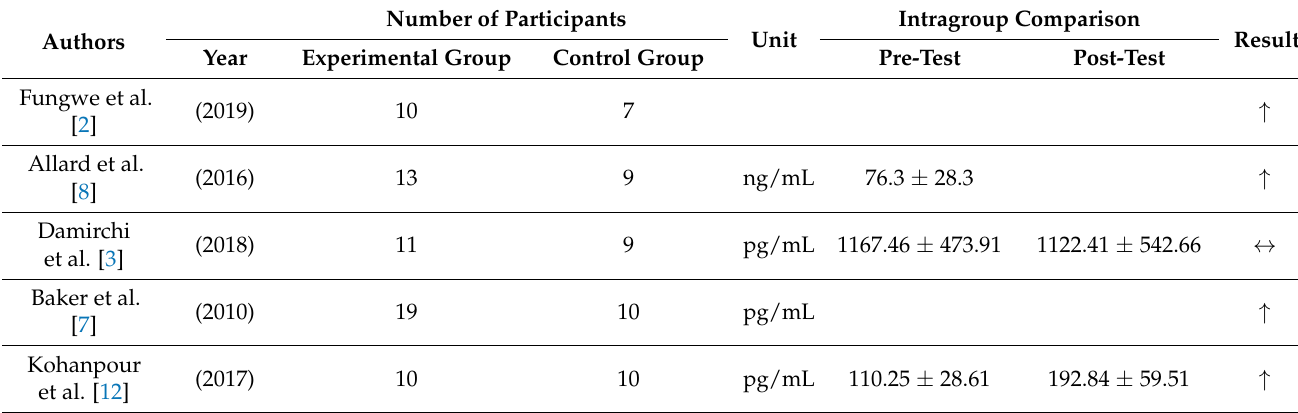
Table 2. The overall results of BDNF in reviewed studies.